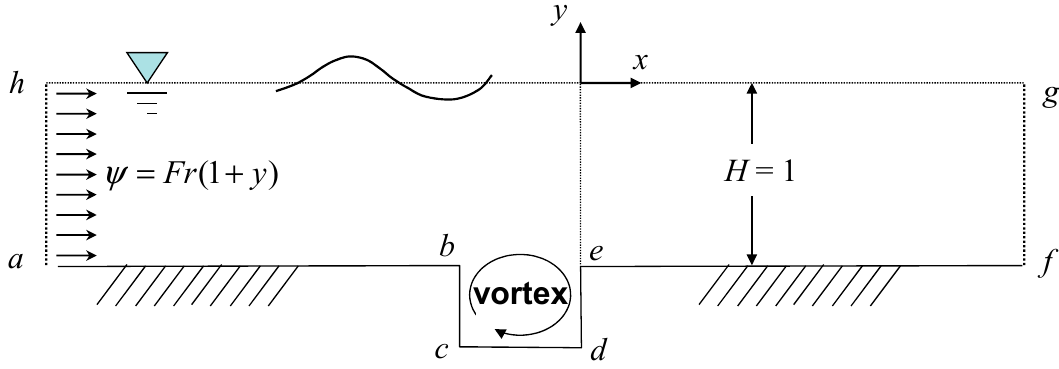
Figure 1. Domain configuration and coordinates.